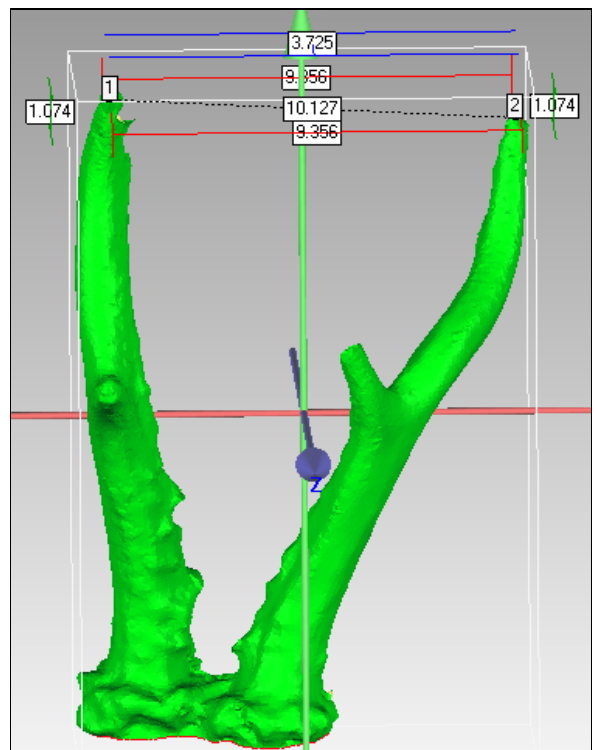
Figure 11. Antlers scale measurement on the 3D model The scale of the antlers refers to the maximum interior